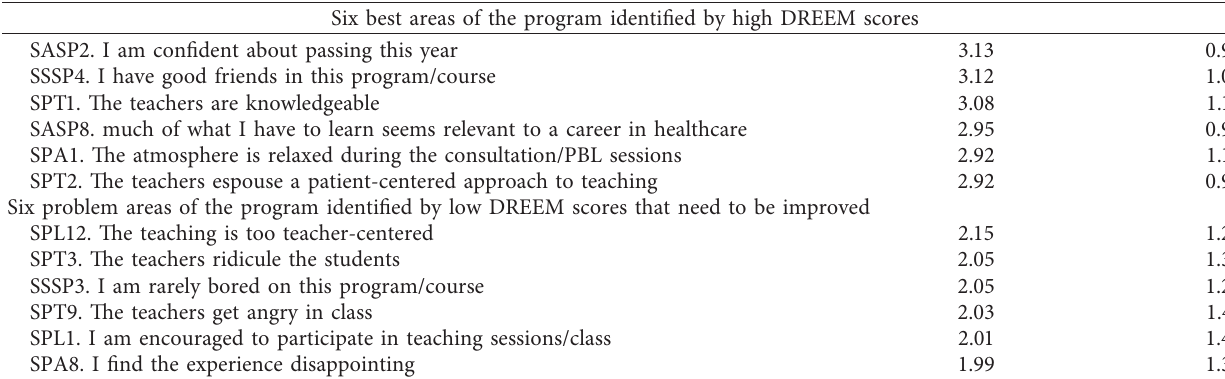
Table 6: Strengths and weaknesses of the program as identified by the DREEM score.